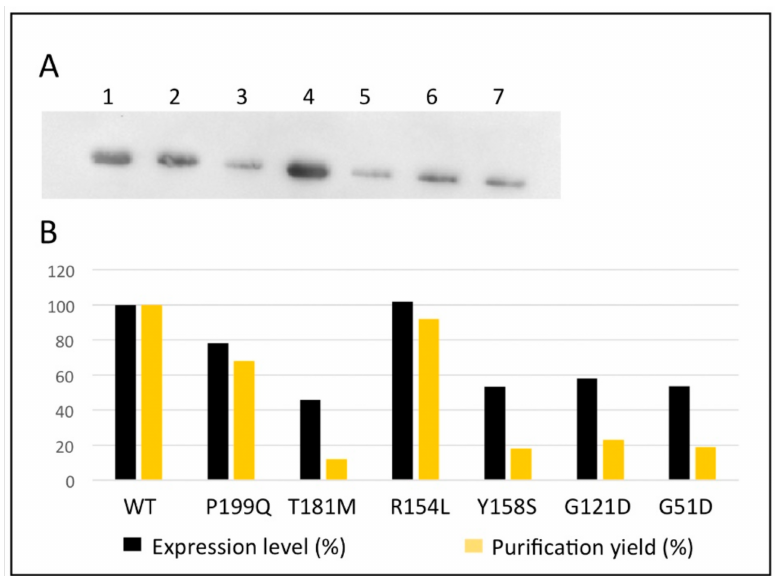
Figure 3. Expression level and yield of purification of the OAT variants. ( A ) Western Blot analysis of the soluble fraction of the E. coli cells lysate expressing (1) hOAT wild-type, (2) P199Q, (3) T181M, (4) R154L, (5) Y158S, (6) G121D and (7) G51D. ( B ) percentage of expression level and yield of purification of the hOAT variants with respect to those of wild-type hOAT. Expression levels were quantified by the ImageJ software on the basis of the mean intensity of the bands of two independent experiments. The percentages of yield of purification of the variants were calculated on the basis of the reported wild-type value of 35 mg/L of